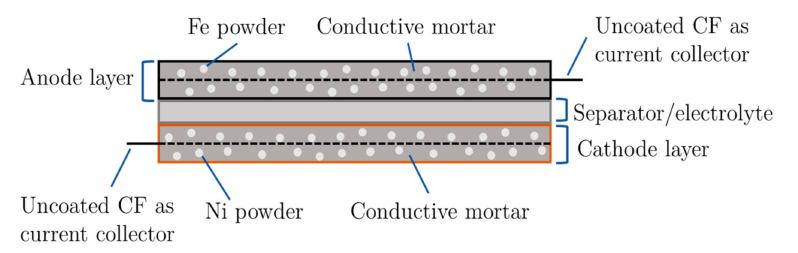
Figure 2. Schematic illustration of the design of the powder-mixing battery.